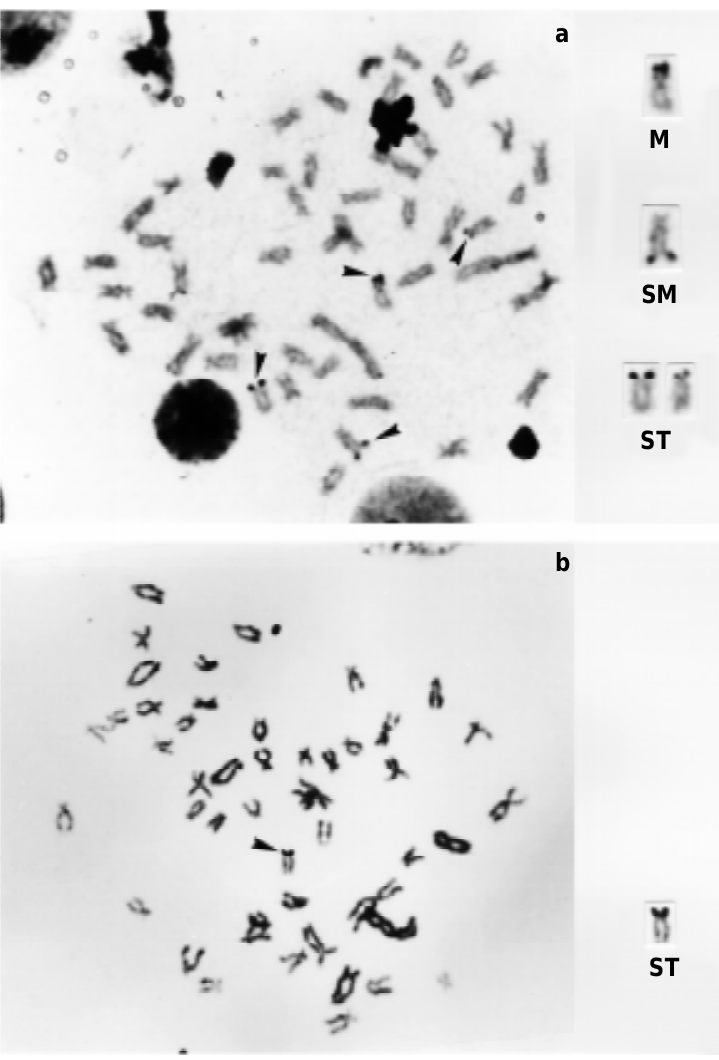
Figure 3 - Somatic metaphases of A. scabripinnis from the Tamanduá stream showing the NOR-bearing chromosomes (ar- rowheads). a , Cytotype I (2n = 50) and b , cytotype II (2n =